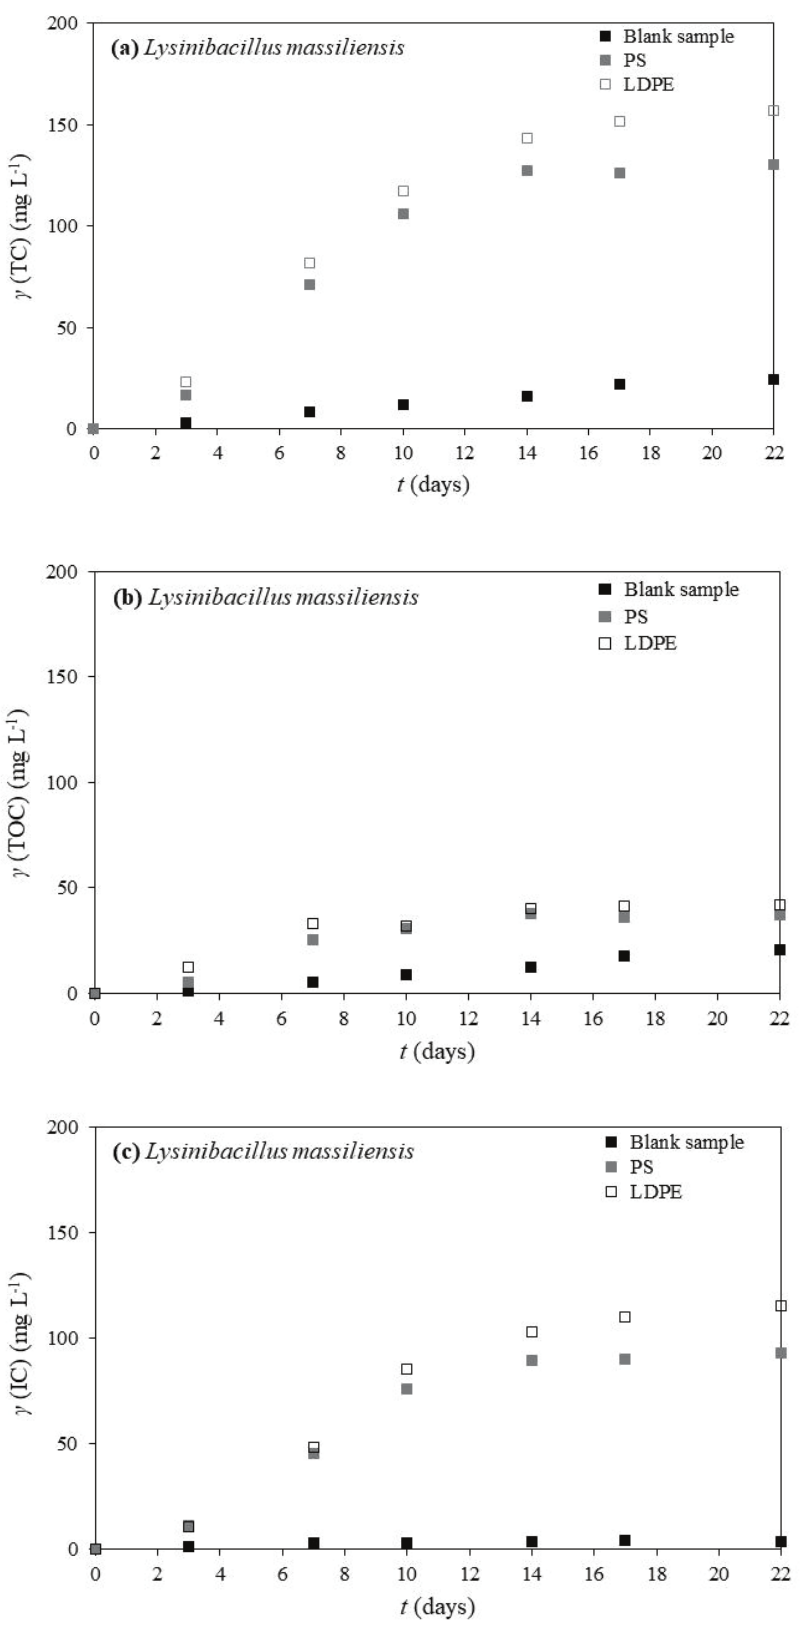
Fig. 6 – Changes in TC (a), TOC (b) and IC (c) concentration during biodegradation of MP-LDPE and MP-PS with bacterial culture Lysinibacillus massiliensis in sterile Erlenmeyer flasks during 22 days (Vr = 100